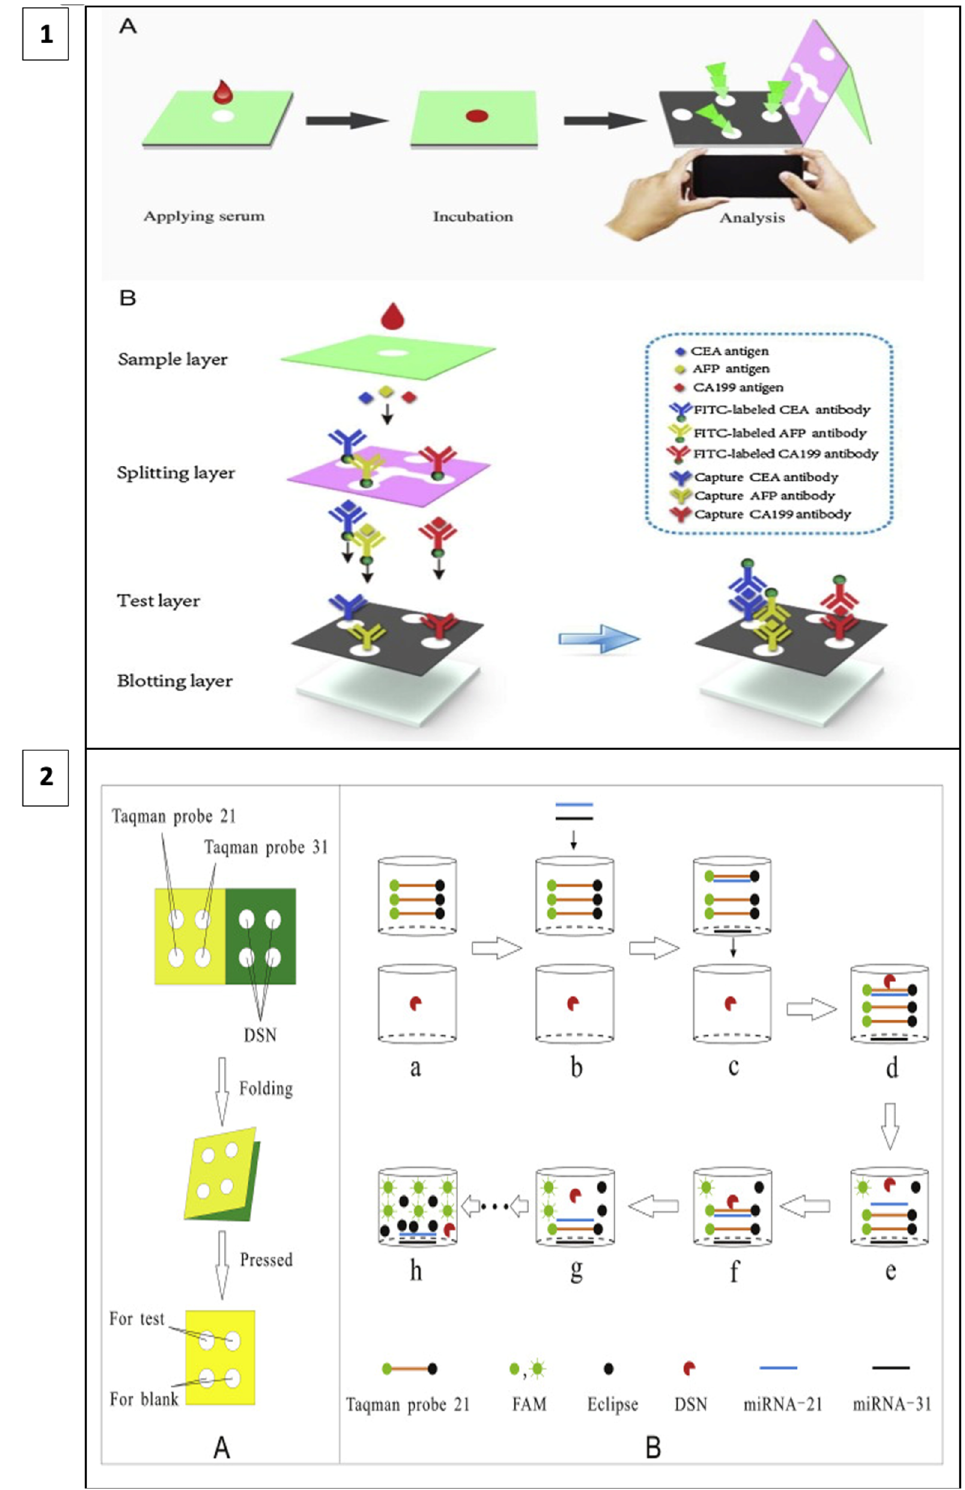
Figure 5. ( 1 ) Three-dimensional vertical flow paper-based microfluidic assay (reprinted with permission from [106]; copyright 2020, Elsevier); ( 2 ) miRNA detection by laser-induced fluorescence µPAD (A) The process of µPAD fabrication. (B) The process of fluorescence amplification for miRNA on µPAD. (reprinted with permission from [107]; copyright 2020, Elsevier).